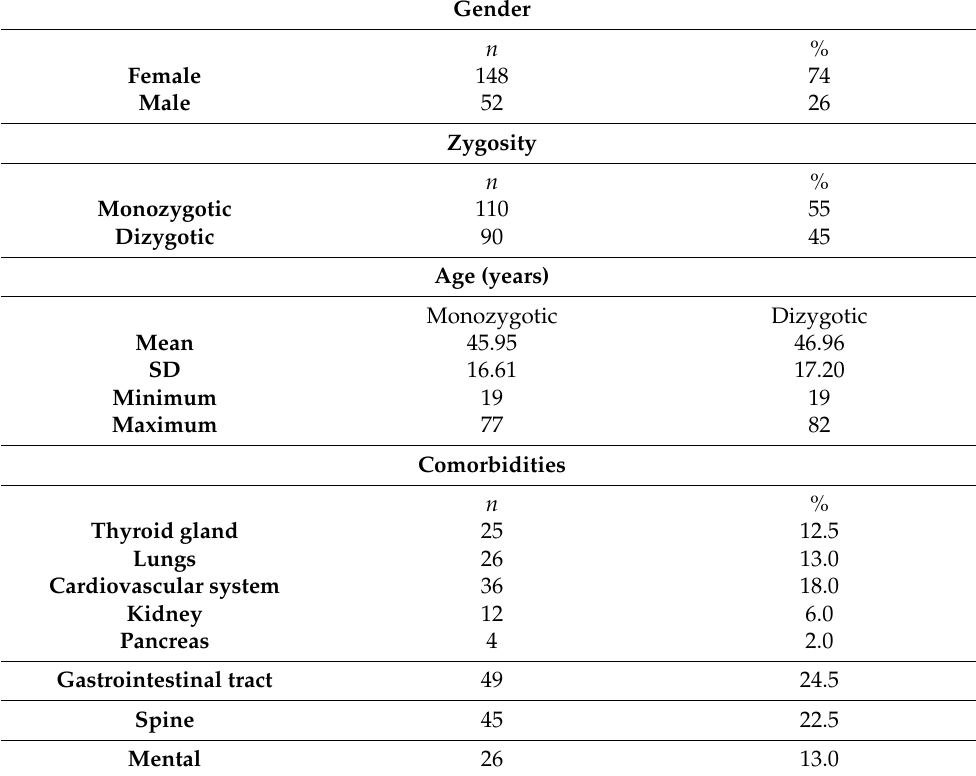
Table 1. Demographics and baseline characteristics of the study